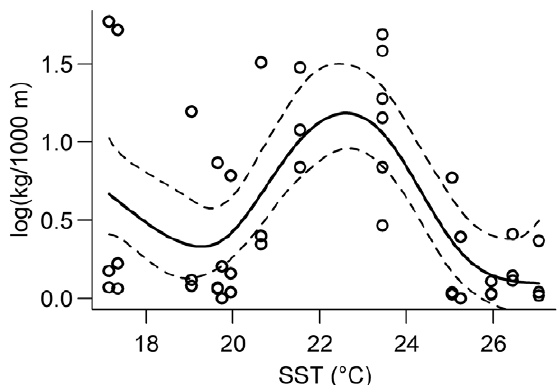
Fig. 6. – Smoothing curves estimated for the Sea Surface Tempera- ture of the GAM model of the biomass index of the discarded spe- cies. Dashed lines represent the 95% confidence